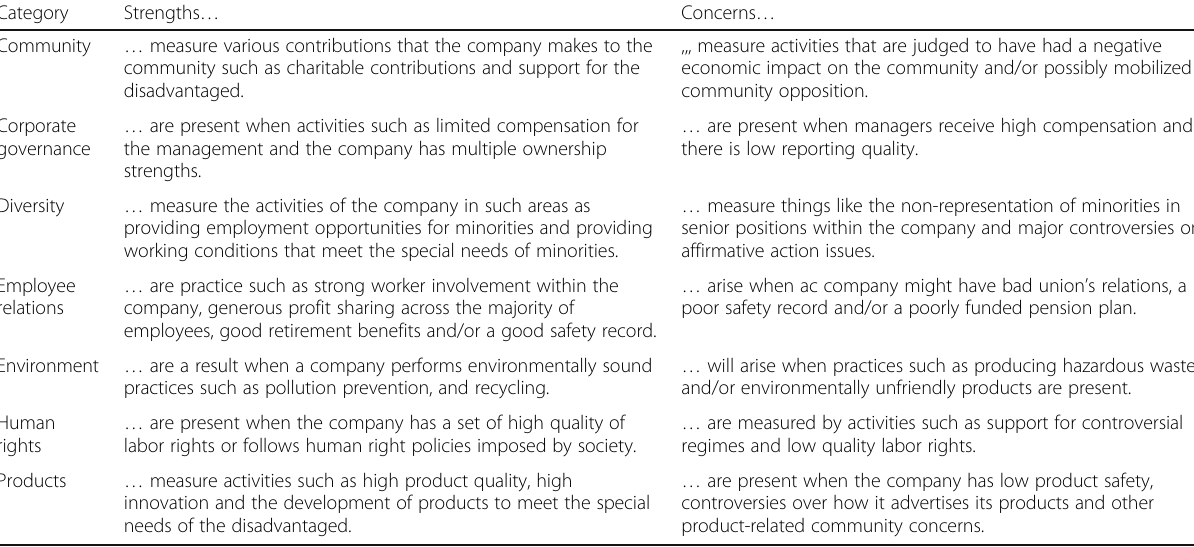
Table 2 Strengths and concerns in KLD categories (based on Bird et al.